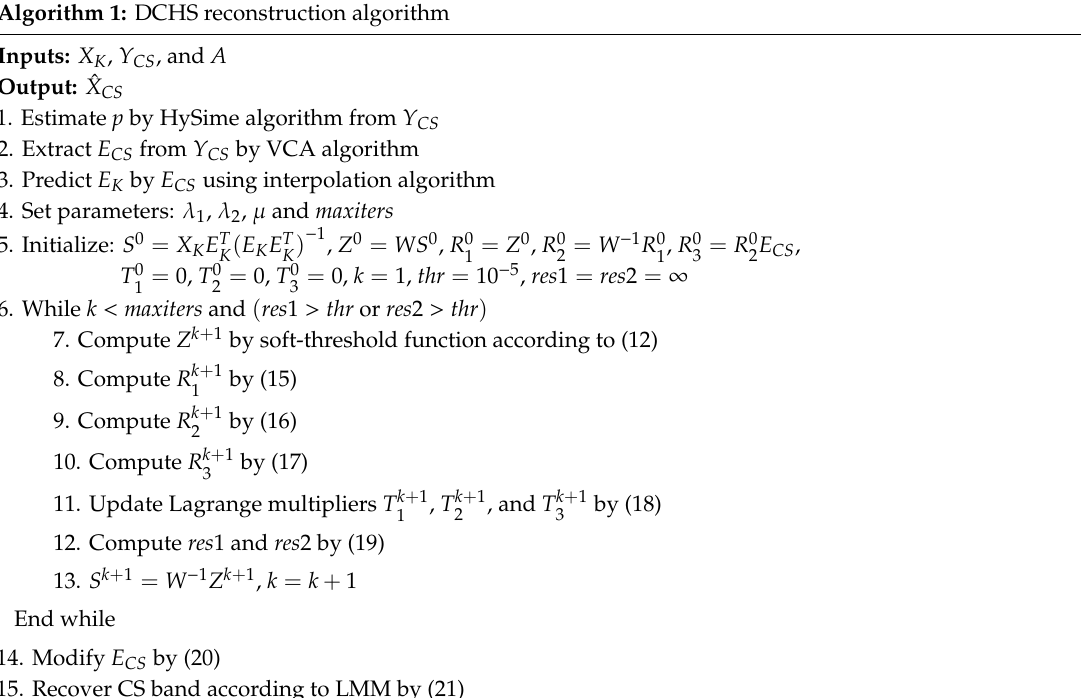
Algorithm 1: DCHS reconstruction